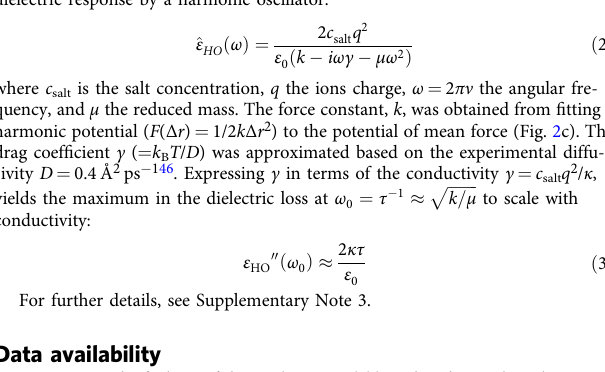
Figs. 3 – 5 and Supplementary Table 1. The dielectric spectra were calculated through Fourier transformation of the system polarization (for details see Sup-